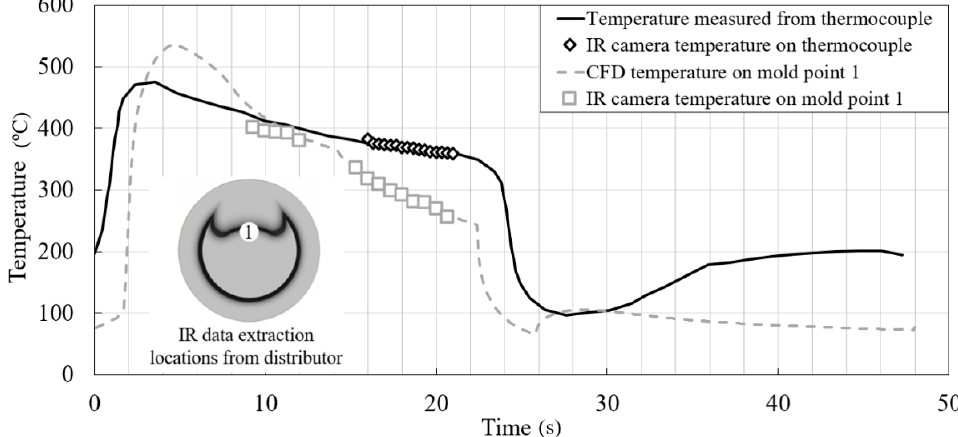
Figure 13. Measured and simulated temperatures on the die during the one-cycle HPDC.